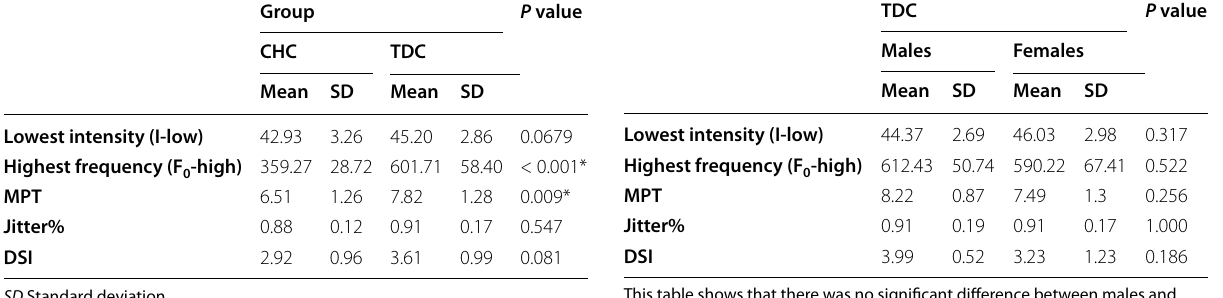
SD Standard deviation